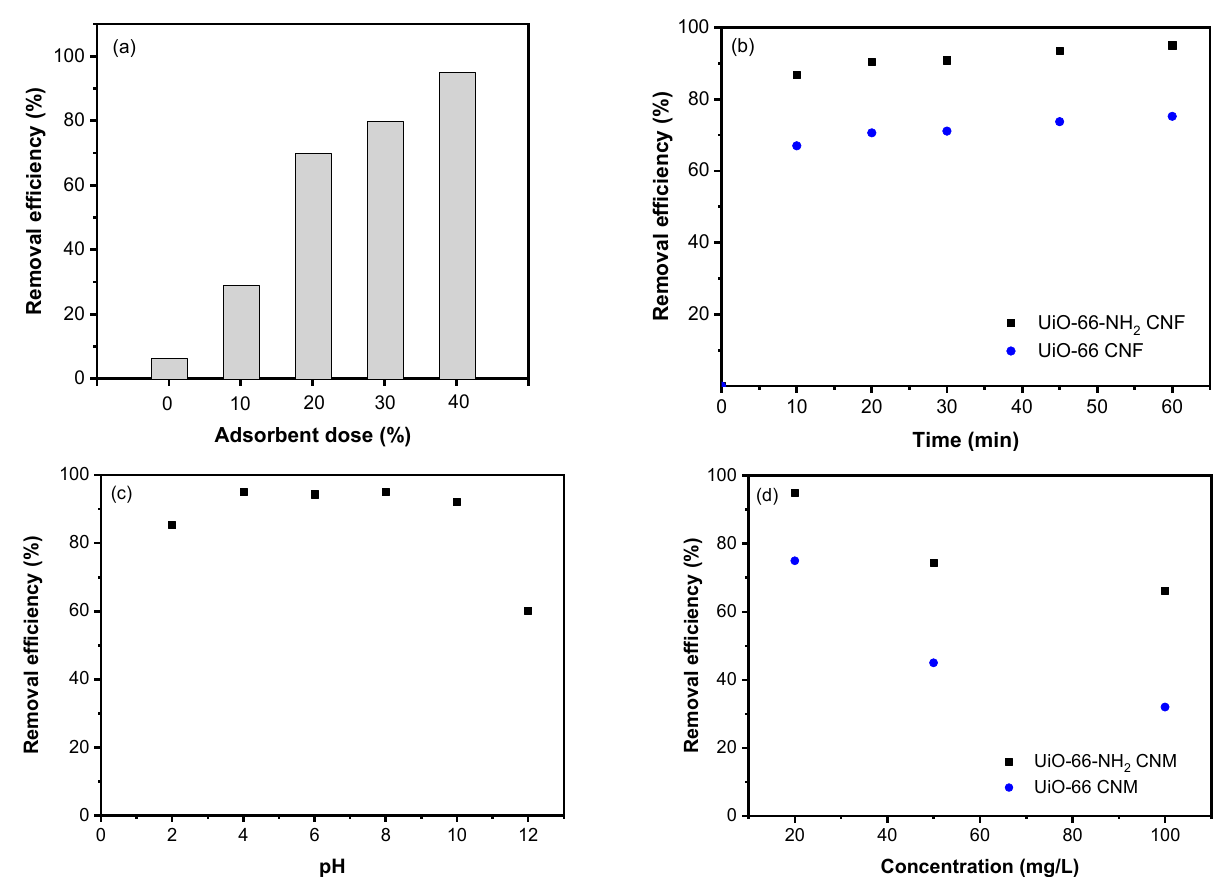
Figure 4. Fluoride adsorption capacity of CNMs as a function of contact time.